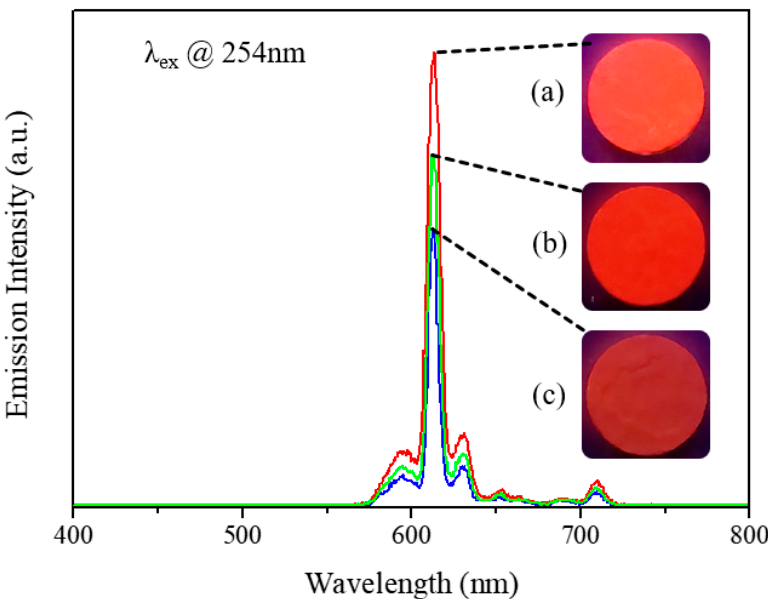
Figure 10. Photoluminescence spectra of Y 2 O 3 :Eu@MF red phosphor calcined at (a) 650 °C, (b) 750 °C, and (c) 850 °C in Figure 9.